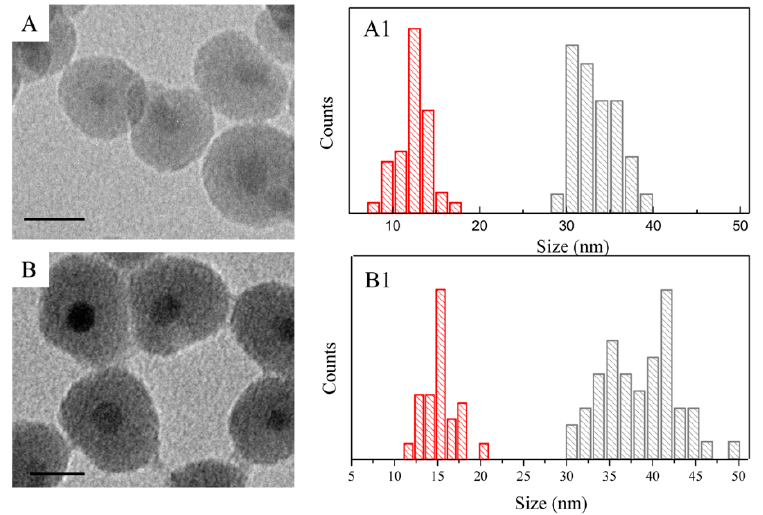
Figure 3. TEM images (A, B) and statistical analysis (A1, B1, performed on 200 nanoparticles (NPs) for each sample) of silica coated GQDs NPs (grey bar graph A1, B1) and silica shell (red bar graph